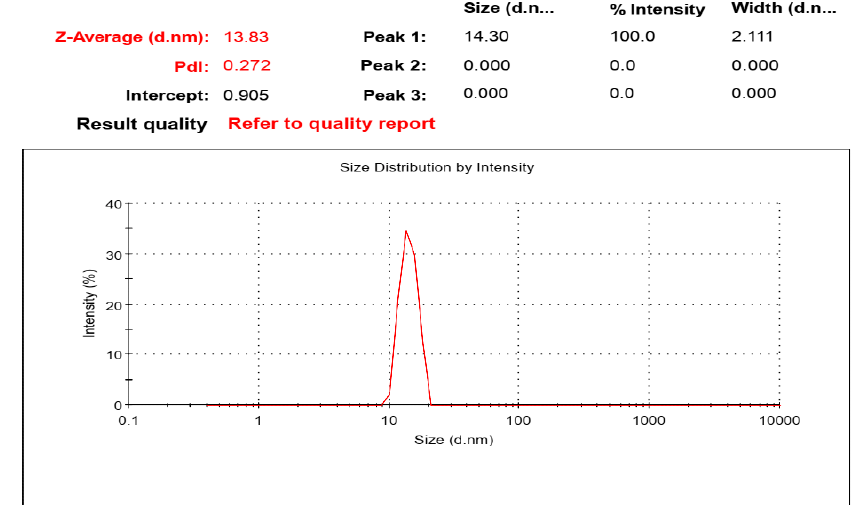
Figure 7. Zeta sizer of synthesized ZnO nanoparticles.